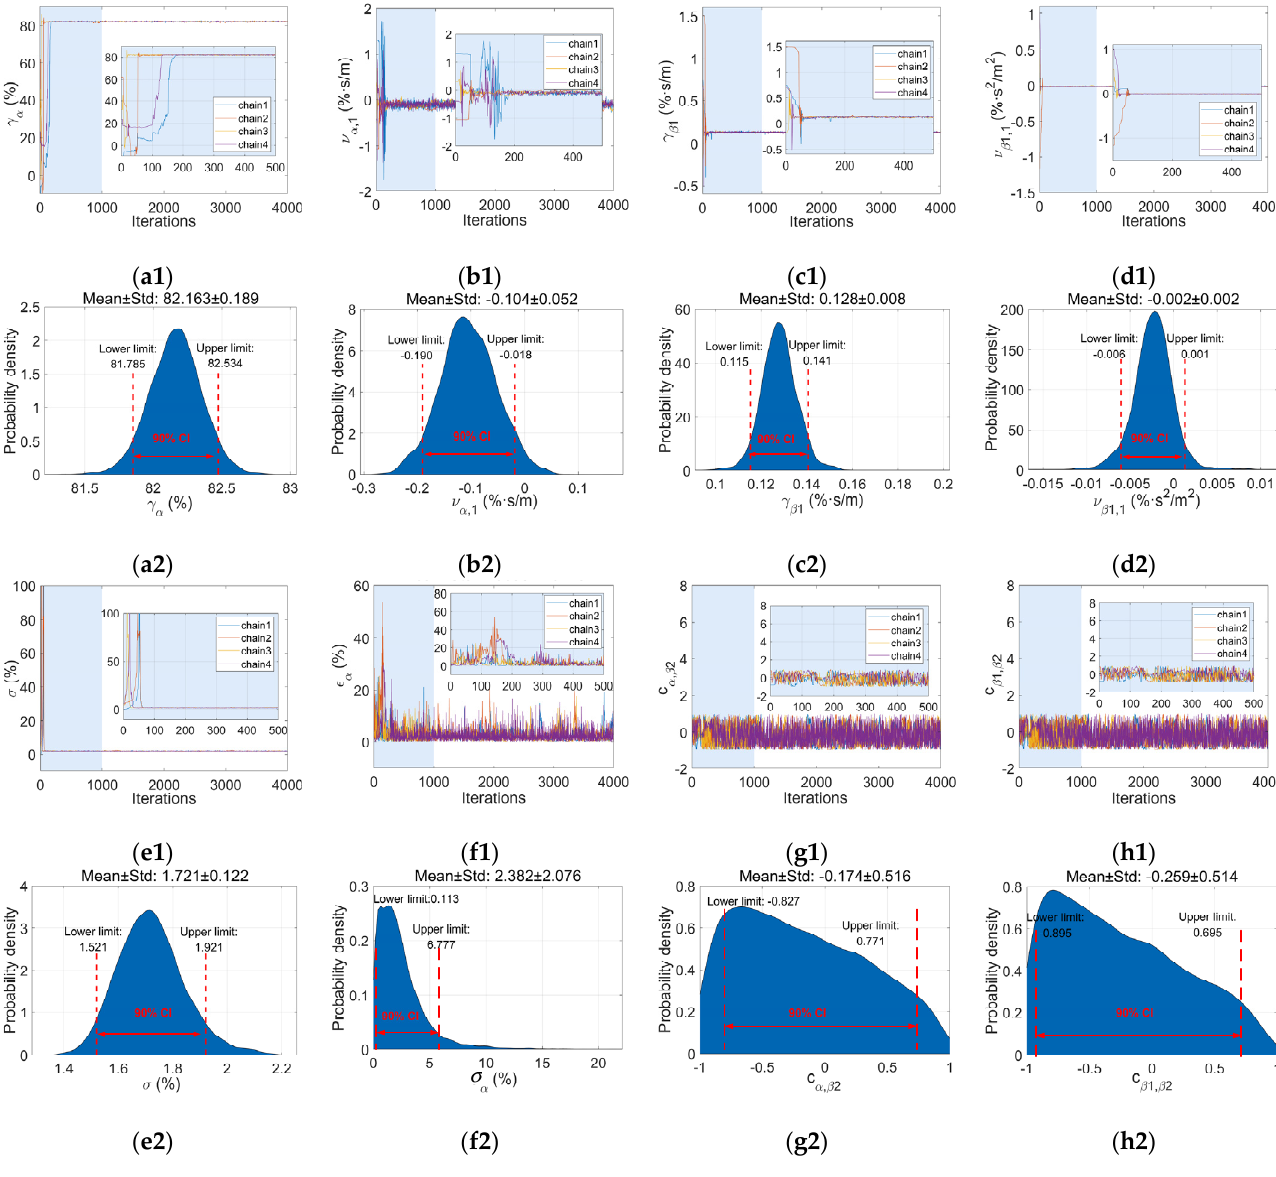
γ , ν , σ , σ α , β β 1 1 ,1 , ν β , σ , σ α , cov α , β , and cov β 1 1 ,1 1 1 , β 2